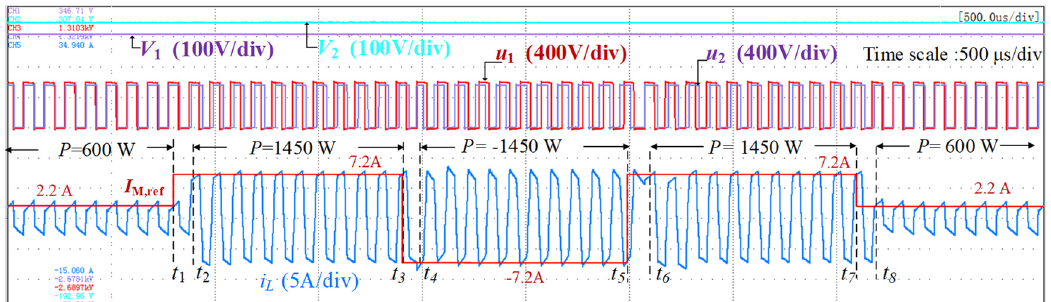
Figure 9. Transient waveforms of bidirectional power transmission.